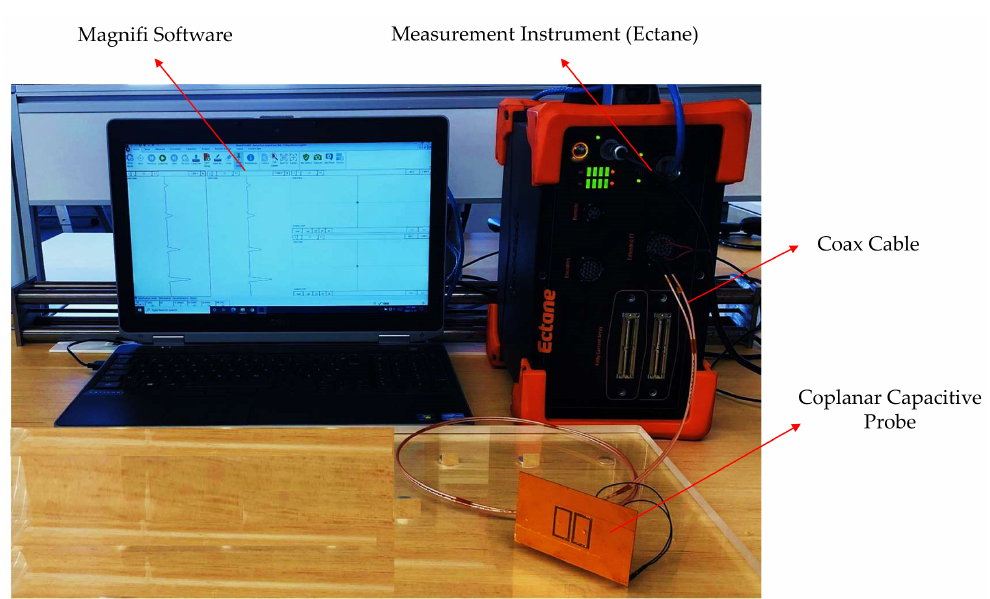
Figure 8. The experimental setup employed for inspecting the RC structure.